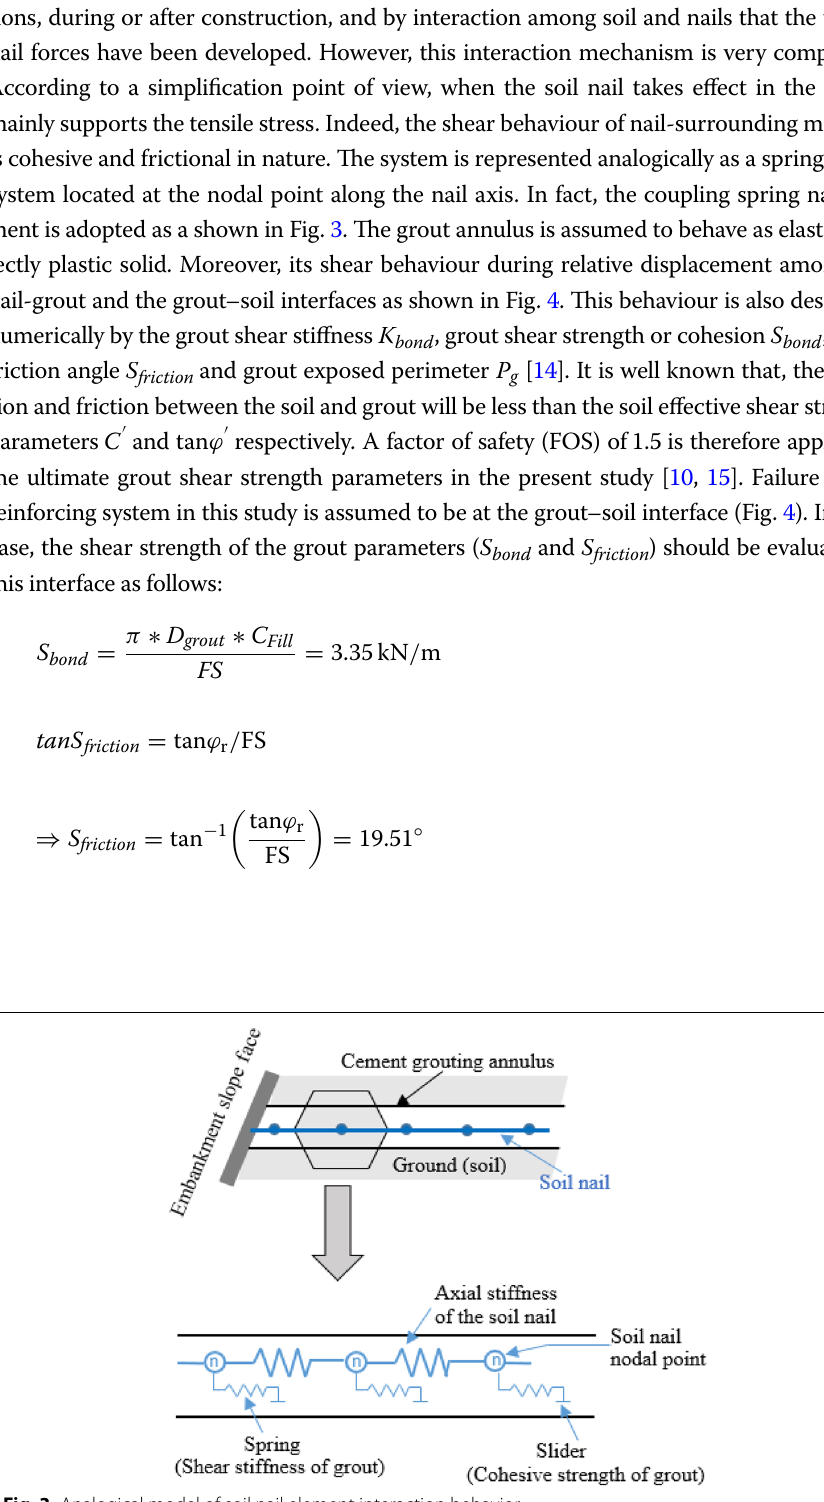
Fig. 3 Analogical model of soil nail element interaction